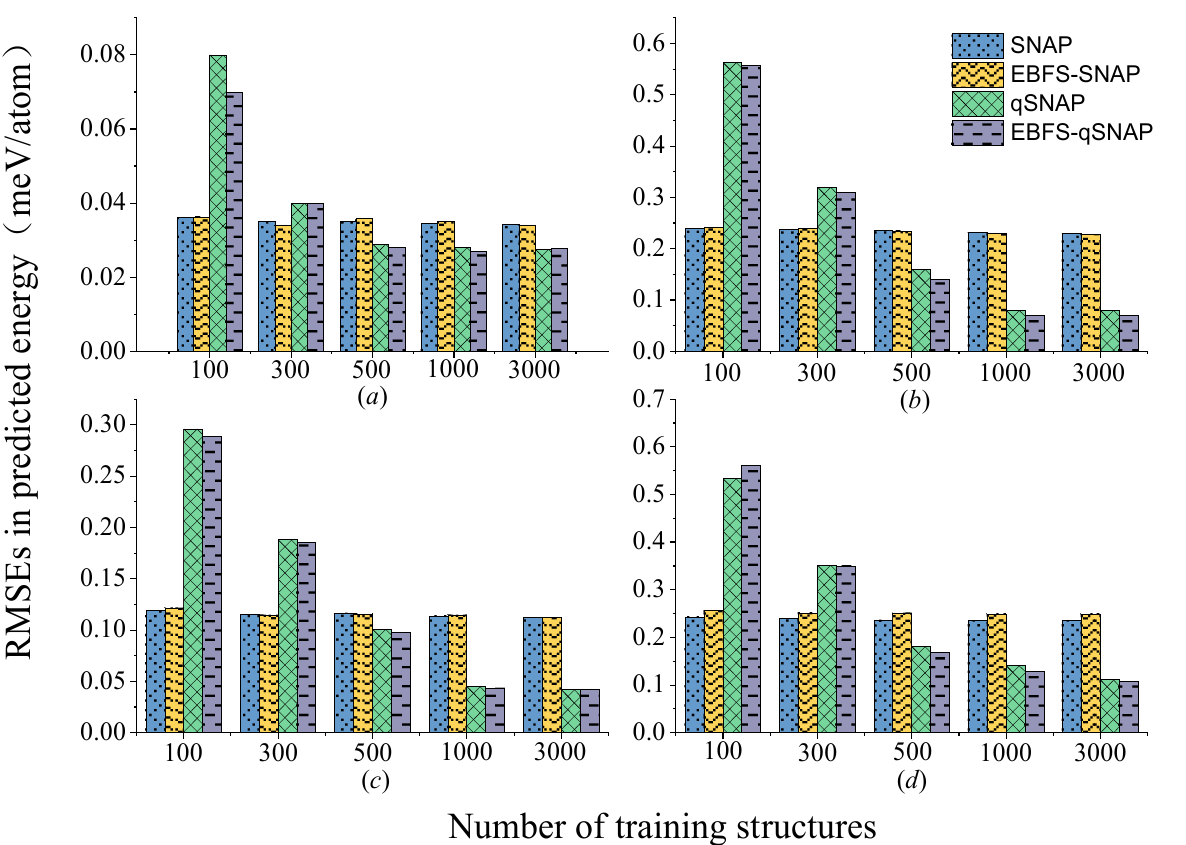
Figure 7. RMSE comparison of energy between EFS-qSNAP and qSNAP, with the number increase in Fe training structures ( a ) bcc Fe; ( b ) fcc Fe; ( c ) hcp Fe; and ( d ) bcc, fcc, and hcp Fe.